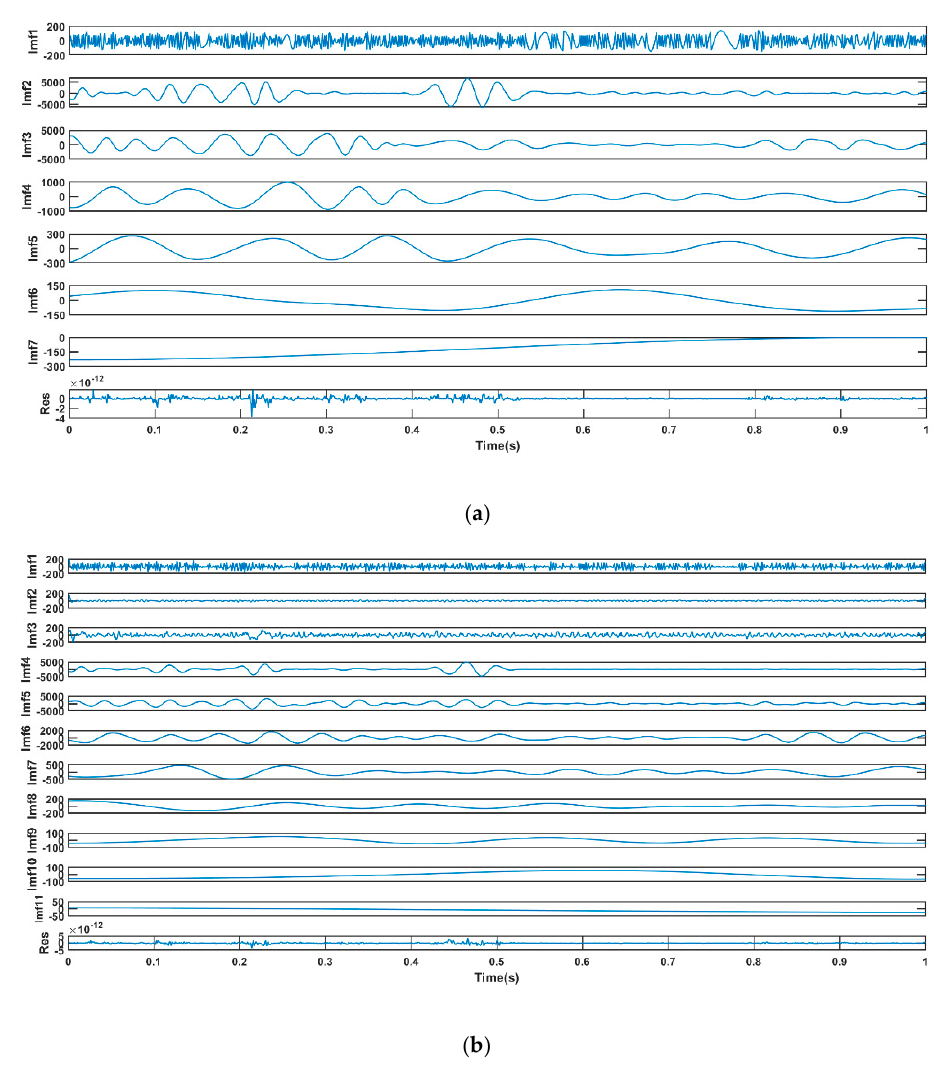
Figure 5. Intrinsic mode functions (IMFs) and residual of empirical mode decomposition (EMD) ( a ) and complete ensemble empirical mode decomposition with adaptive noise (CEEMDAN) ( b ).